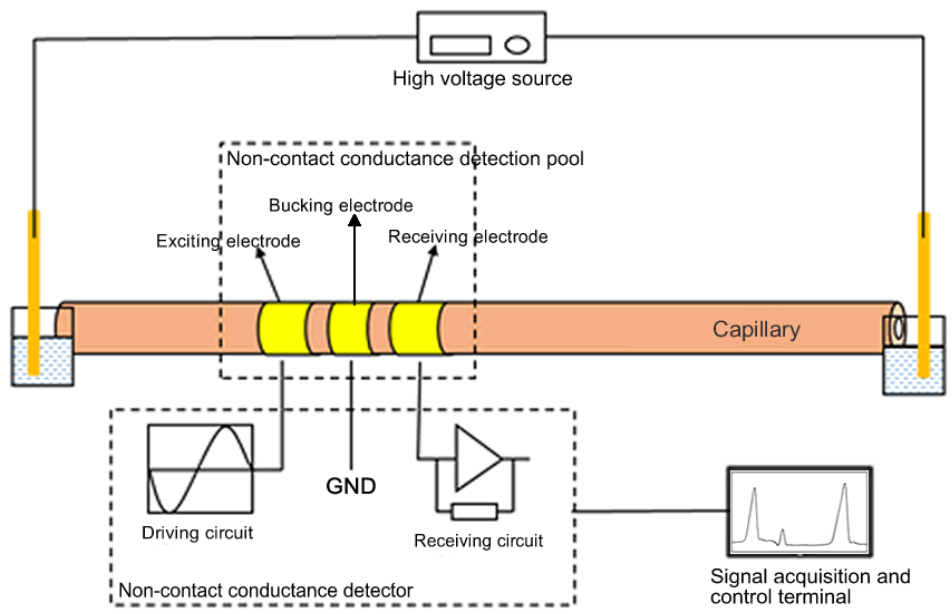
Figure 2. Structure of capacitive coupled contactless conductivity detection device.